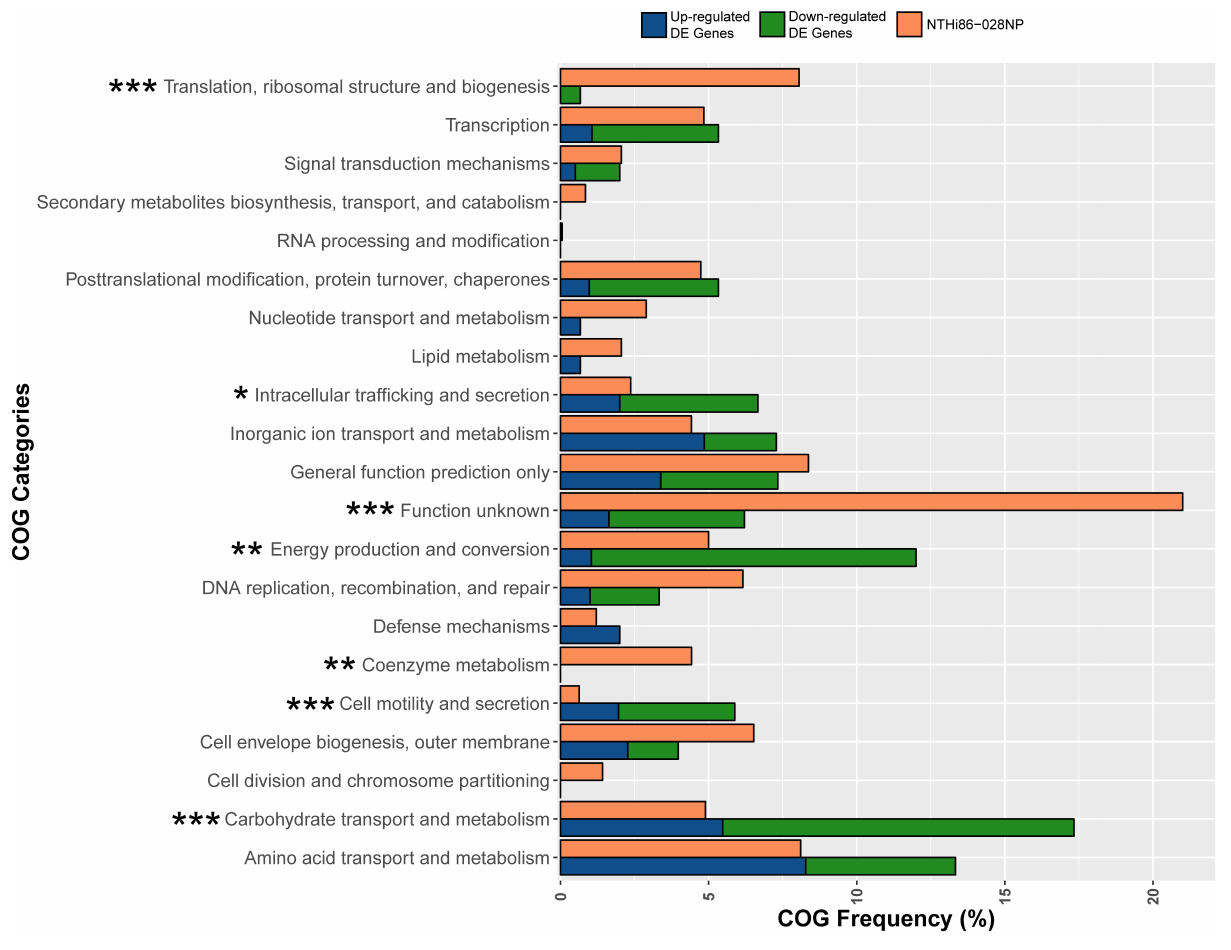
FIGURE 3 | Clusters of Orthologous Group (COG) analysis comparing the frequency of categories in the 86-028NP genome with all DE genes in the 12 NP-BAL pairs. Seven COG categories were significantly enriched in DE genes from BAL-derived isolates, comprising four over-represented categories ( Carbohydrate transport and metabolism, Cell motility and secretion, Energy production and conversion and Intracellular trafficking , and secretion ) that were majority downregulated and three under-represented categories ( Coenzyme metabolism, Function unknown, and Translation, ribosomal structure and biogenesis ). ∗∗∗ p < 0.001, ∗∗ p < 0.01, ∗ p <